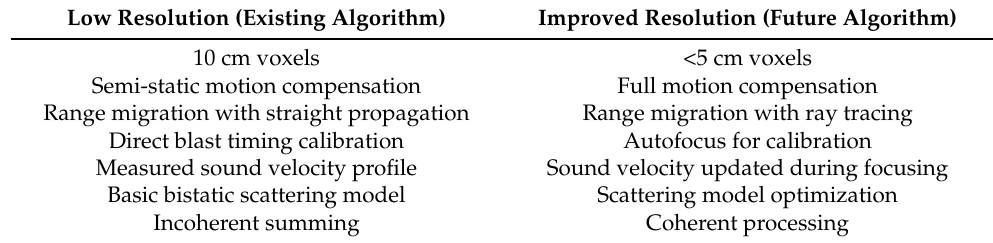
Table 1. Signal processing